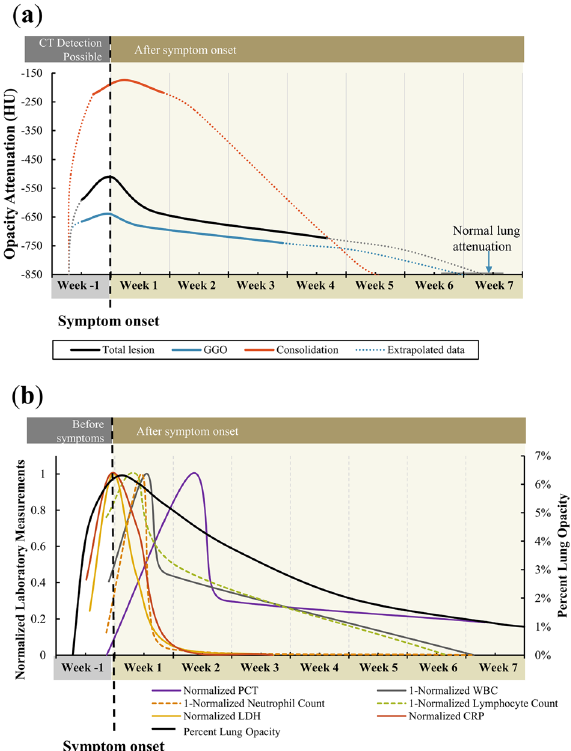
Figure 4. Dynamic curves of lesion attenuation and laboratory measurements. ( a ) Dynamic curves for COVID-19 lesion attenuation or density. The total lesion attenuation (black) and subtypes (GGO = blue, consolidation = red) are shown overtime and were generalized from 29 patients with sequential CTs. The dotted lines show the data extrapolated to normal lung attenuation. ( b ) Dynamic laboratory measurements over time for COVID-19-positive patients. The generalized and normalized curves for PCT (purple), 1-WBC (gray), LDH (yellow), CRP (red) with total percent lung involvement (black).